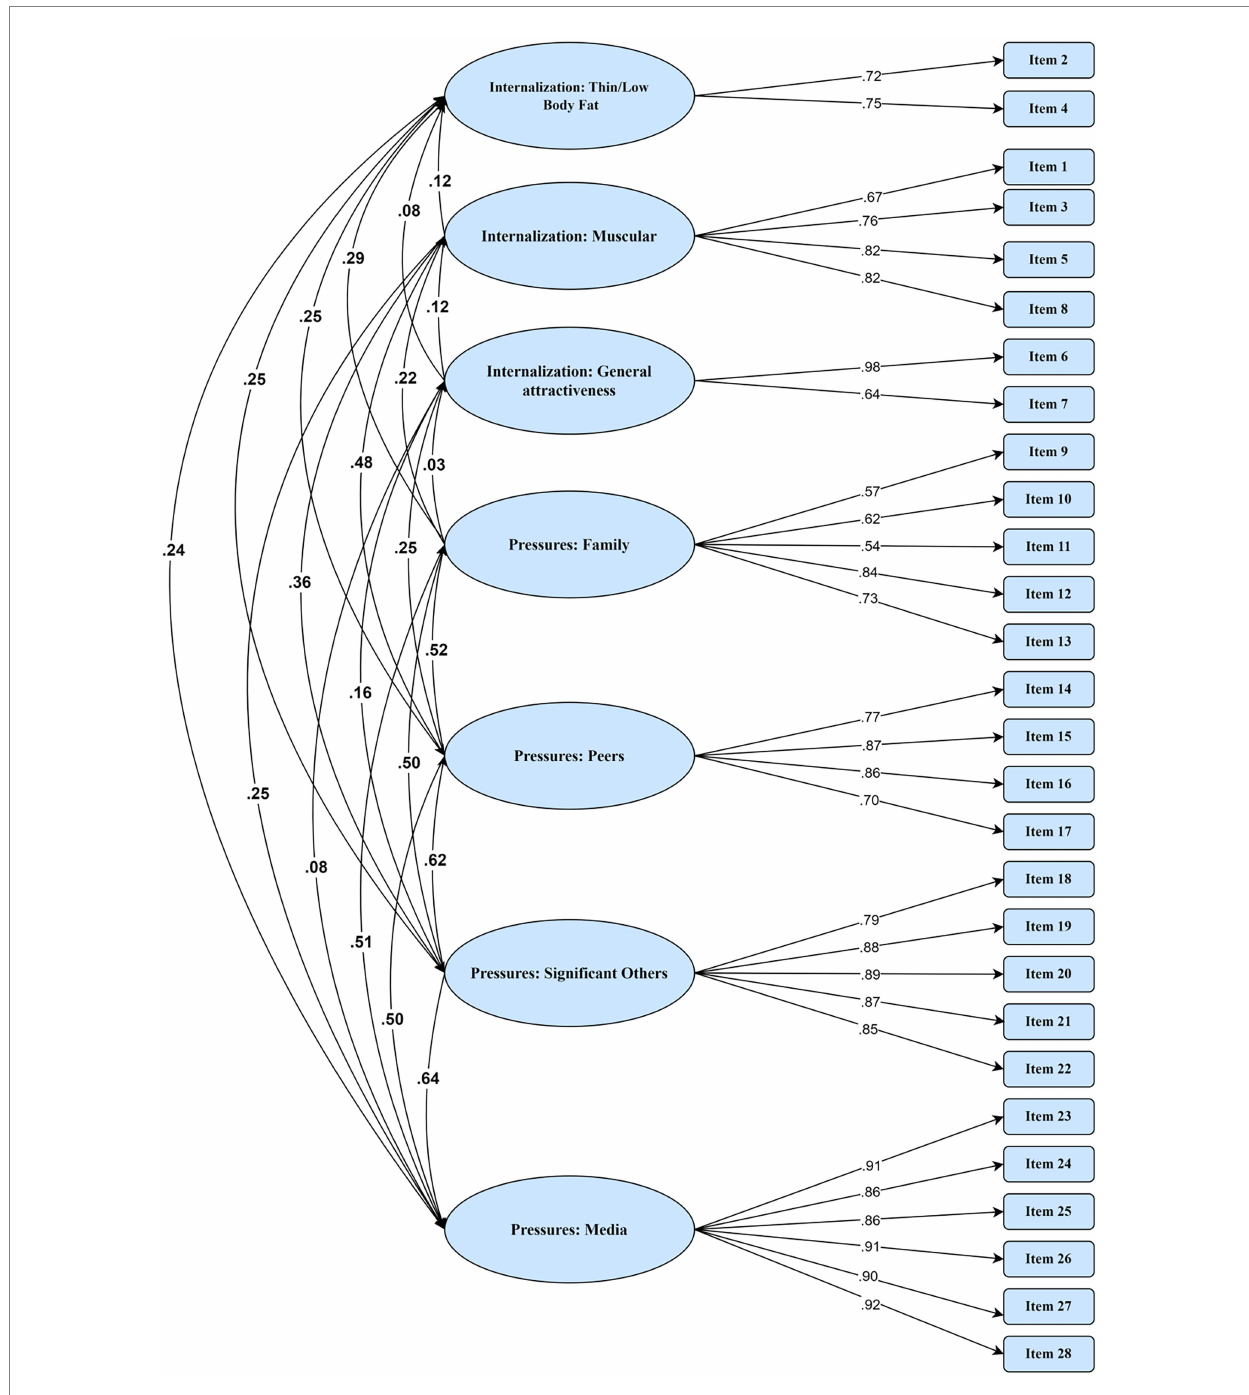
FIGURE 1 Confirmatory factor analysis for female